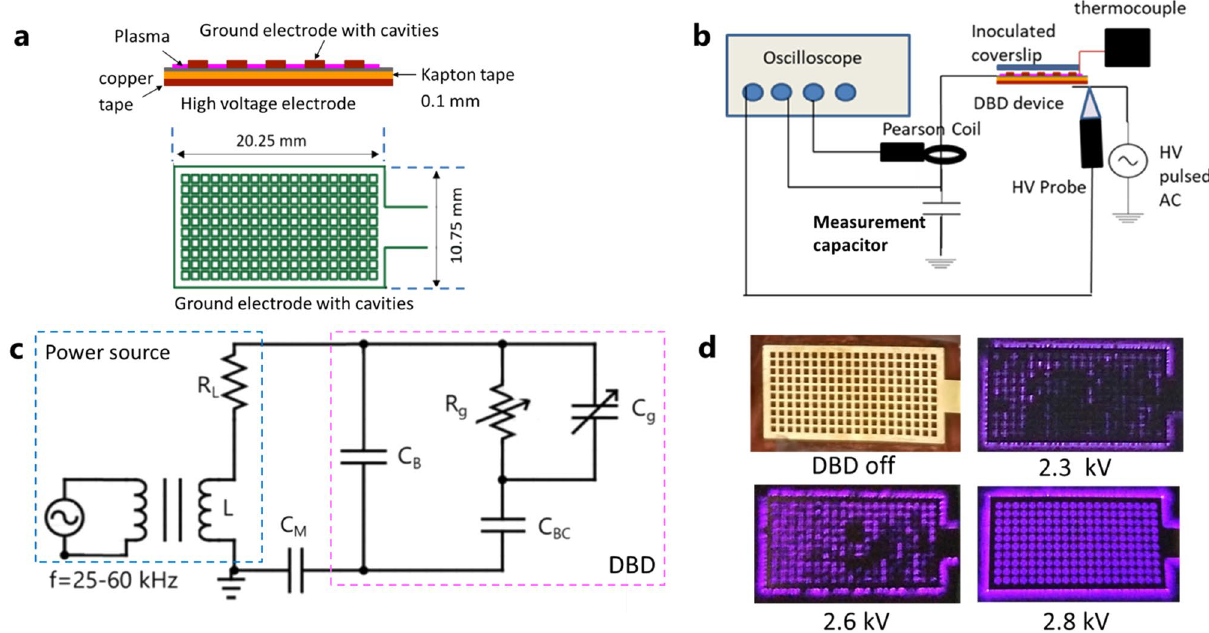
Figure 1. The flex-DBD is based on a printed circuit design and operates at < 3 kV, ~ 40 kHz, < 0.5 W/cm 2 supplied by a portable power source. ( a ) The design of flex-DBD consists of conducting (copper) and insulating (polyimide) layers and a patterned ground electrode. ( b ) The experimental setup includes a portable pulsed ac high voltage (HV) source and monitoring apparatus (oscilloscope). The patterned electrode and HV source are globally grounded. A coverslip inoculated with a bacteria sample is placed on top of the ground electrode. ( c ) The equivalent circuit, where C B is the capacitance of the flex-DBD device excluding the rectangular cavities, C BC is the capacitance of the solid portion and C g and R g are the capacitance and resistance of the open air portion of the cavities, C M is the measurement capacitor, and L and R L are the inductance and the resistance of the secondary coil of the high voltage transformer of the high frequency power source. ( d ) As the applied voltage increases, a greater part of the surface of flex-DBD lights